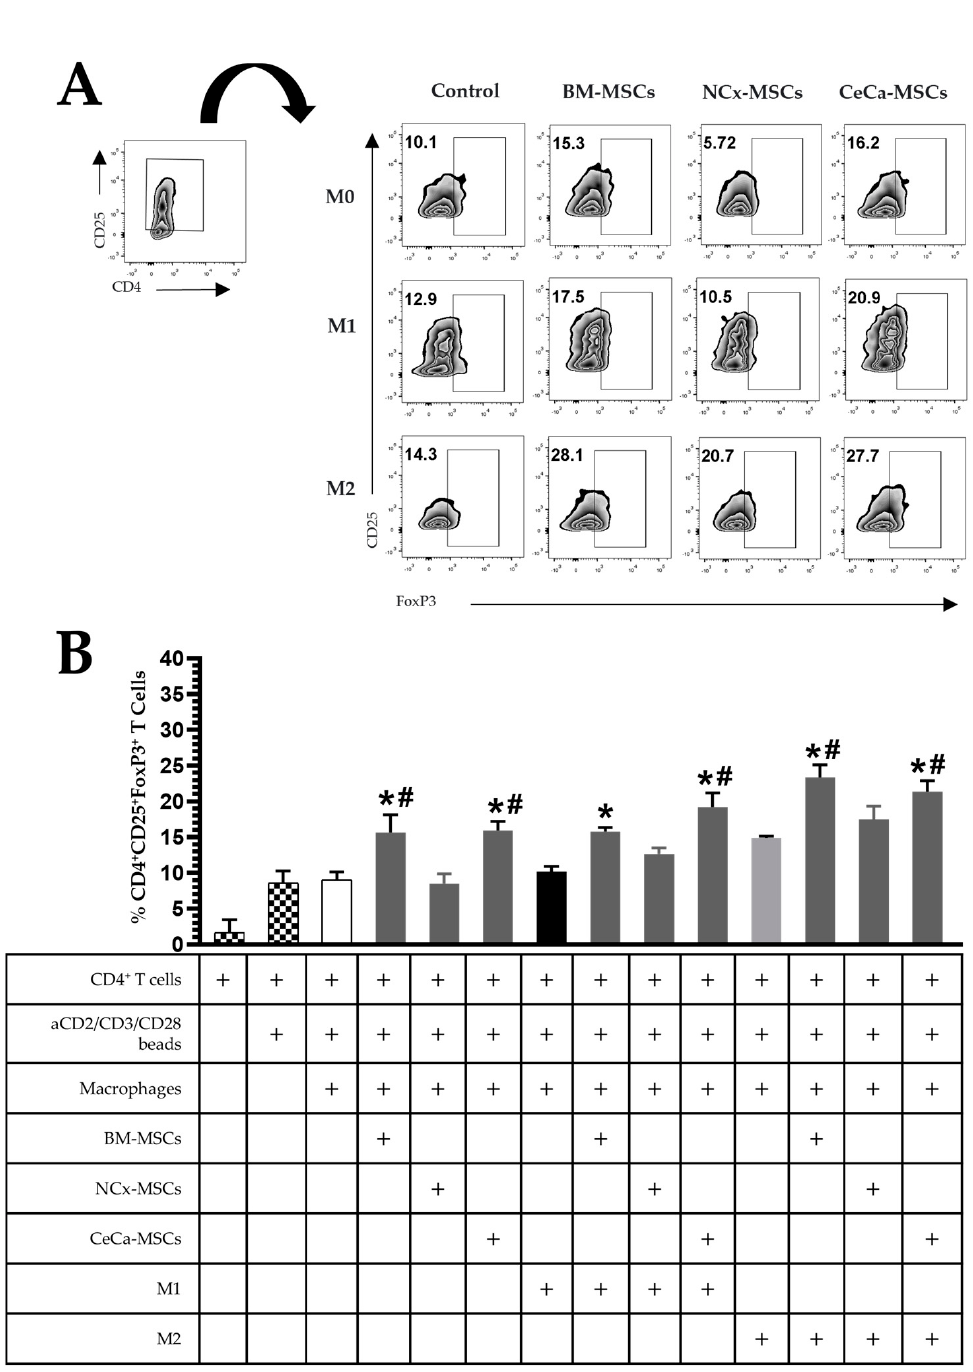
Figure 5. CeCa-MSCs, unlike NCx-MSCs, increase the ability of macrophages to generate CD4 + CD25 + FoxP3 + regulatory T lymphocytes. ( A ) Plot representative of the percentage of CD4 + CD25 + FoxP3 + regulatory T lymphocytes. ( B ) Bar graph of the percentage of CD4 + CD25 + FoxP3 + regulatory T lymphocytes. Bar graphs represent the mean and standard deviation. * Significant difference from the control, # significant difference from NCx-MSCs ( p < 0.05); n = 6. M0, absence of inducer medium; M1, inducer medium for M1 polarization; M2, inducer medium for M2 polariza- tion.